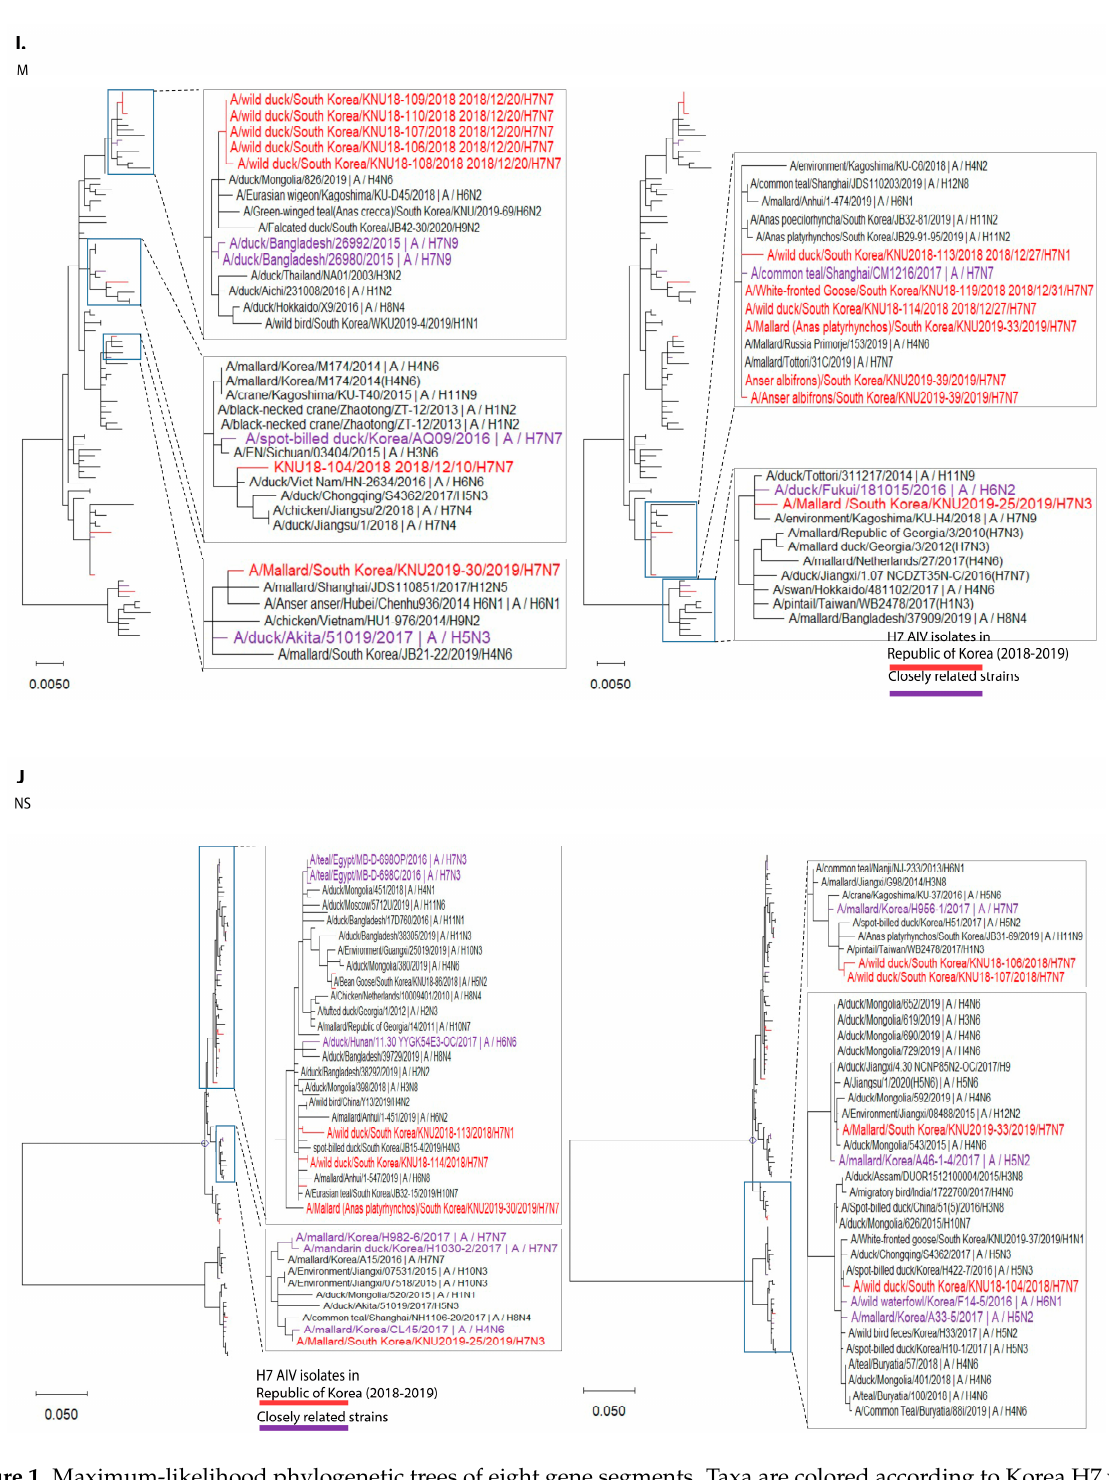
Figure 1. Maximum-likelihood phylogenetic trees of eight gene segments. Taxa are colored according to Korea H7 virus 2018/2019 isolates (red) and closely related strains (originated before 2018), based on highest nucleotide similarities to the 2018-2019 Korea H7 viruses (purple). ( A ) polymerase basic 2 (PB2); ( B ) polymerase basic 1 (PB1); ( C ) polymerase acidic (PA); ( D ) haemagglutinin (HA); ( E ) neuraminidase (NA7); ( F ) neuraminidase (NA1); ( G ) neuraminidase (NA3); ( H ) nucleoprotein (NP); ( I ) matrix (M); ( J ) non-structural